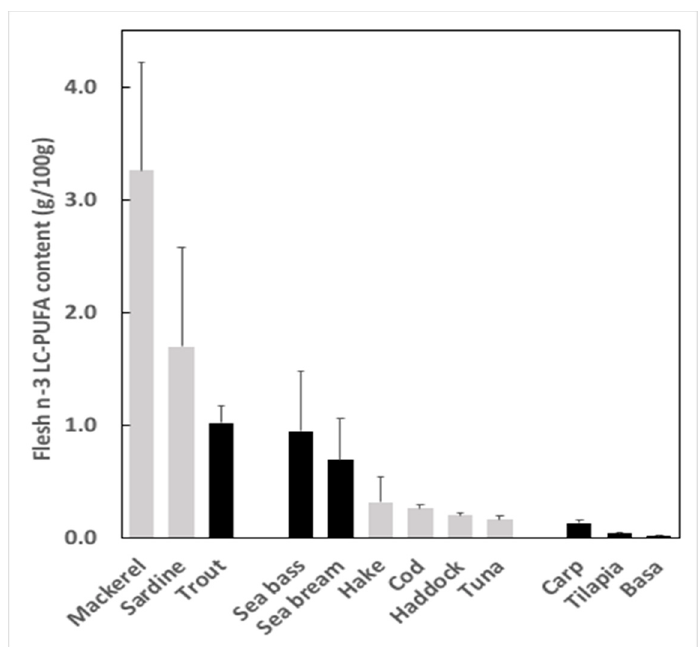
Figure 3. Content of n-3 long-chain polyunsaturated fatty acids (LC-PUFA) in flesh of fish species common in seafood markets including oily species, Atlantic mackerel ( Scomber scombrus ), sardine ( Sardina pilchardus ) and rainbow trout ( Oncorhynchus mykiss ); marine species, Atlantic cod ( Gadus morhua ), Atlantic haddock ( Melanogrammus aeglefinus ), European hake ( Merluccius merluccius ), European sea bass ( Dicentrarchus labrax ), gilthead sea bream ( Sparus aurata ) and Yellowfin tuna ( Thunnus albacares ); freshwater species, common carp ( Cyprinus carpio ), basa ( Pangasius bocourti ) and tilapia ( Oreochromis niloticus ). Data are presented as g n-3 LC-PUFA per 100 g flesh and are means ± SD and are taken from Sprague et al. [33,34] and Sprague (unpublished data). Bar colour denotes whether the analysis was of farmed (black) or wild (grey) samples.